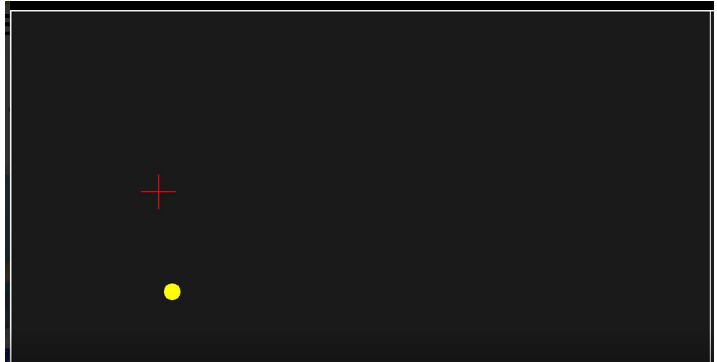
Figure 1. An example of treatment. Coloured circles map the screen at the border of the visual field